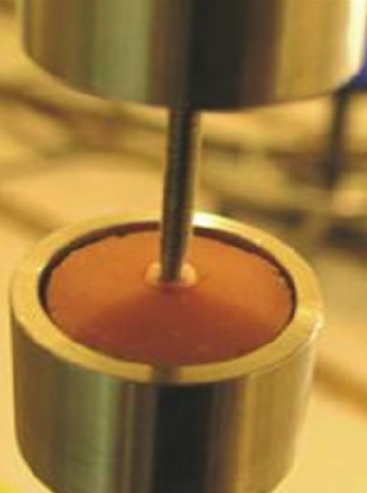
Figure 4: Spherical tip ( r = 5mm) was aligned with the center of the canal opening of each